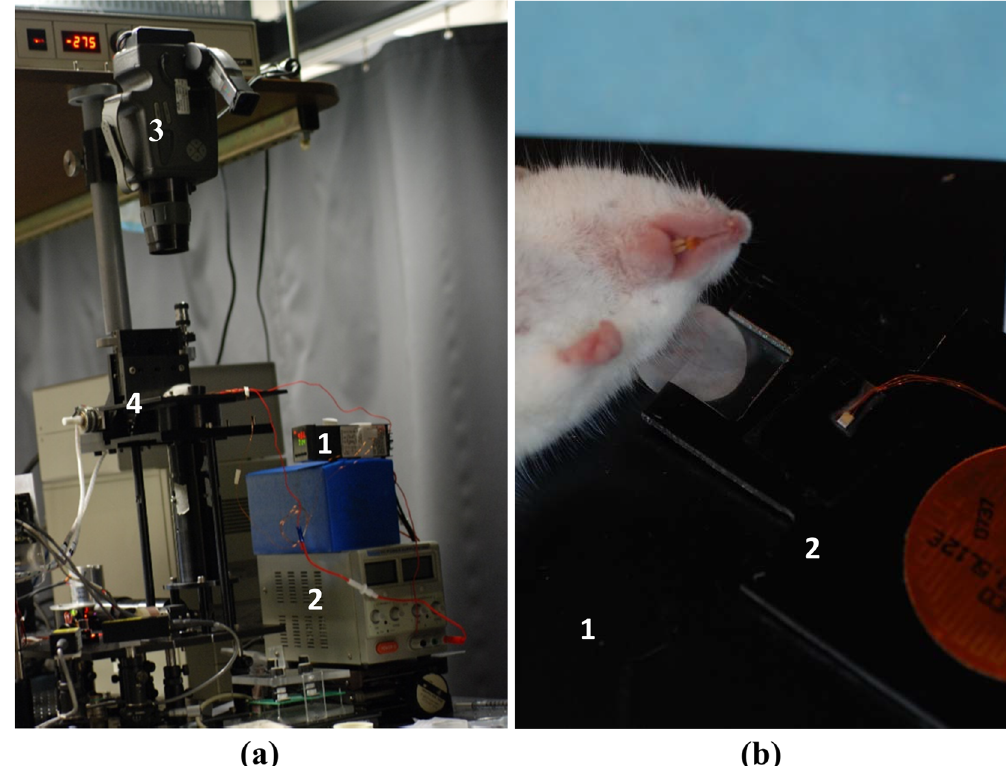
Figure 5. Imaging experiments lay-out. ( a ) Reflectance confocal microscope with heating apparatus and thermal camera. External temperature controller (1) and power supply (2) were used to heat and maintain the desired tissue temperature. Thermal camera (3) was positioned above the sample stage (4) to provide independent temperature monitoring. ( b ) Picture of mouse ear positioning on the sample stage (1) of the confocal microscopy system. Ear tissue was heated using the same heating apparatus (2) as for the integrating sphere